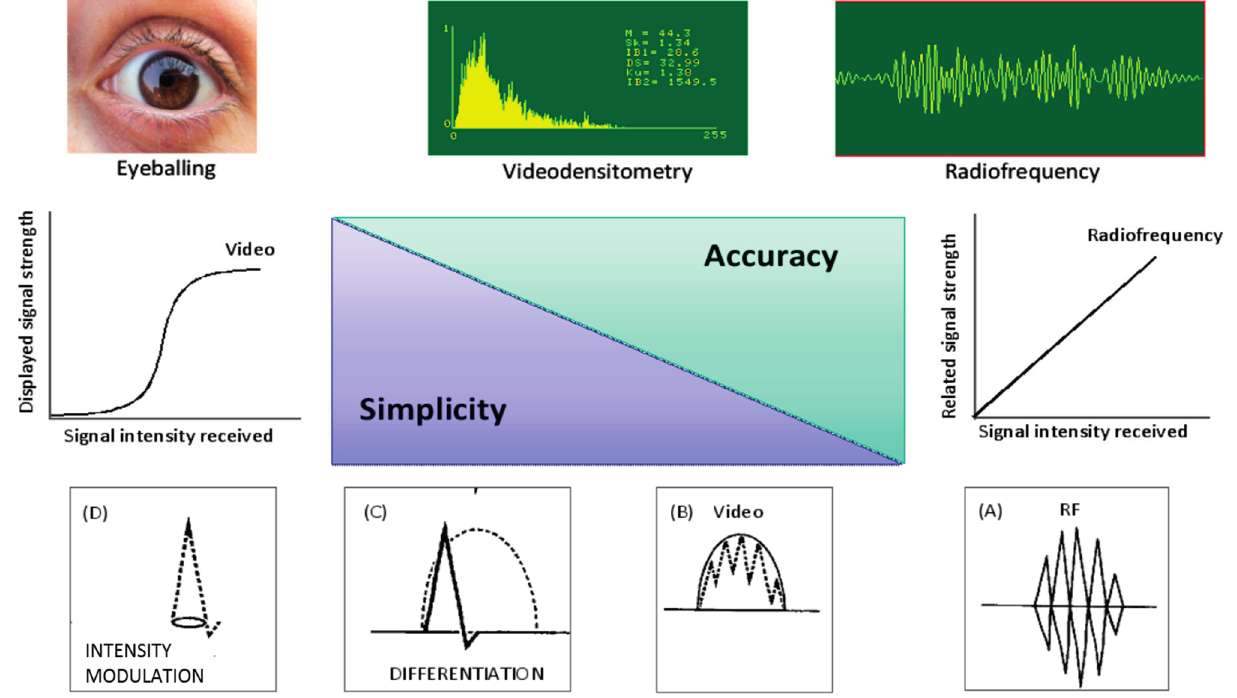
Figure 1. Approaches to tissue characterization: visual eyeballing analysis; videodensitometric analysis of digitized image by descriptors of image brightness and gray level